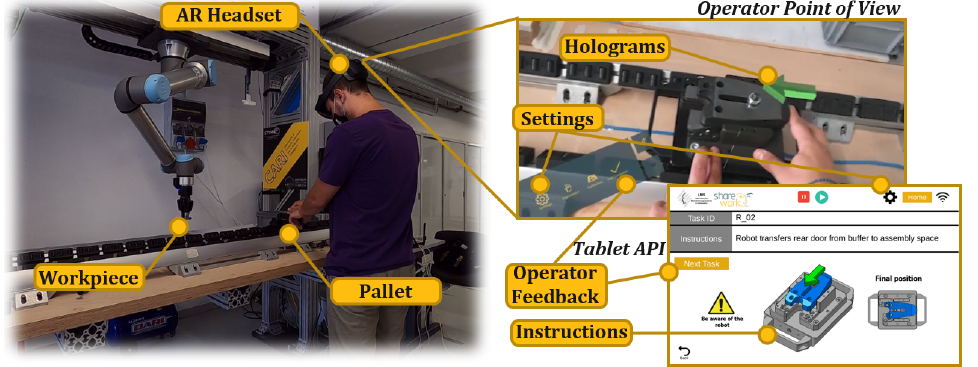
Figure 9. Demonstrator setup and HS-SH interaction module.